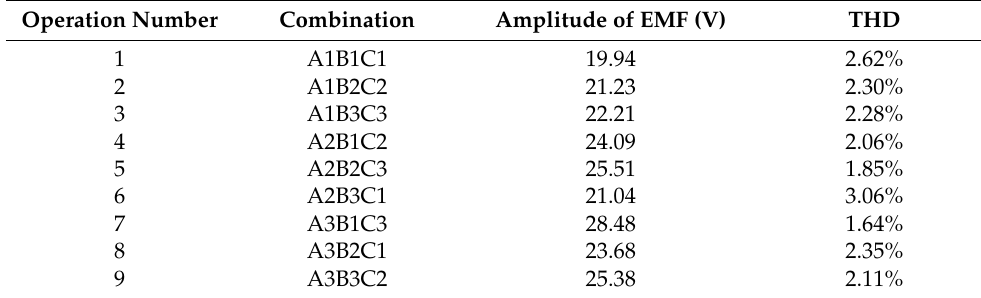
Table 3. Orthogonal design